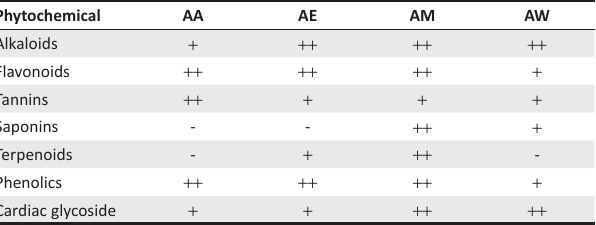
TABLE 1: Phytochemical components of leaves of Acalypha